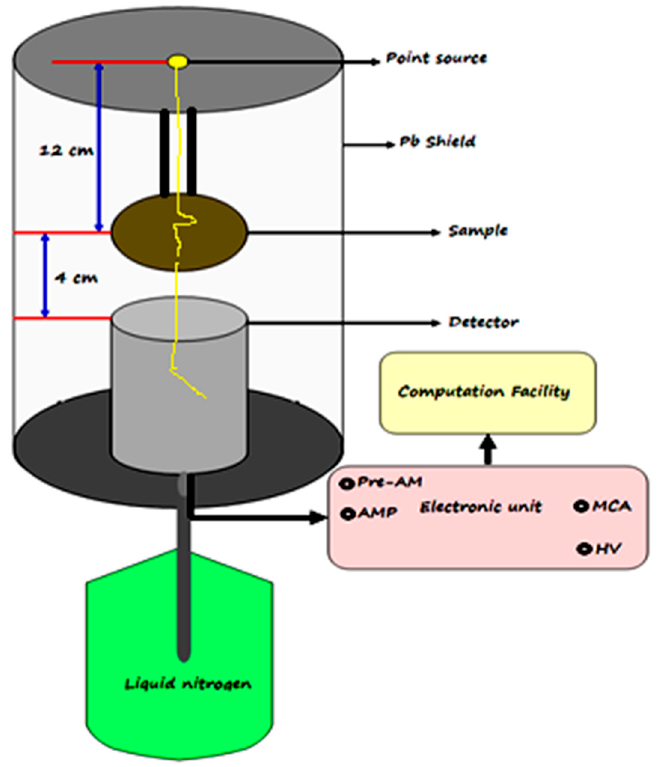
Figure 3. The geometry of the experimental gamma-rays attenuation measurements.